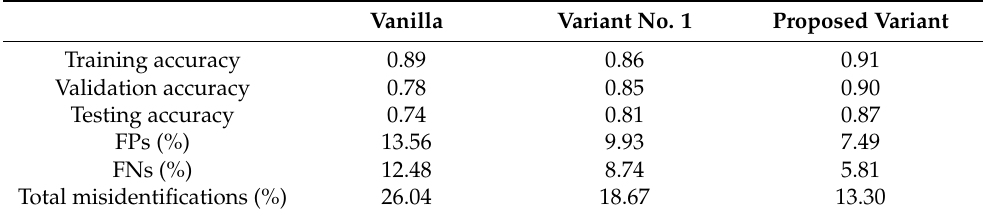
Table 6. Results of the ablation study for the baseline (vanilla) U-net, a variant with a dropout layer placed after the convolutional layers, and the proposed variant. Vanilla Variant No. 1 Proposed Variant Training accuracy 0.89 0.86 0.91 Validation